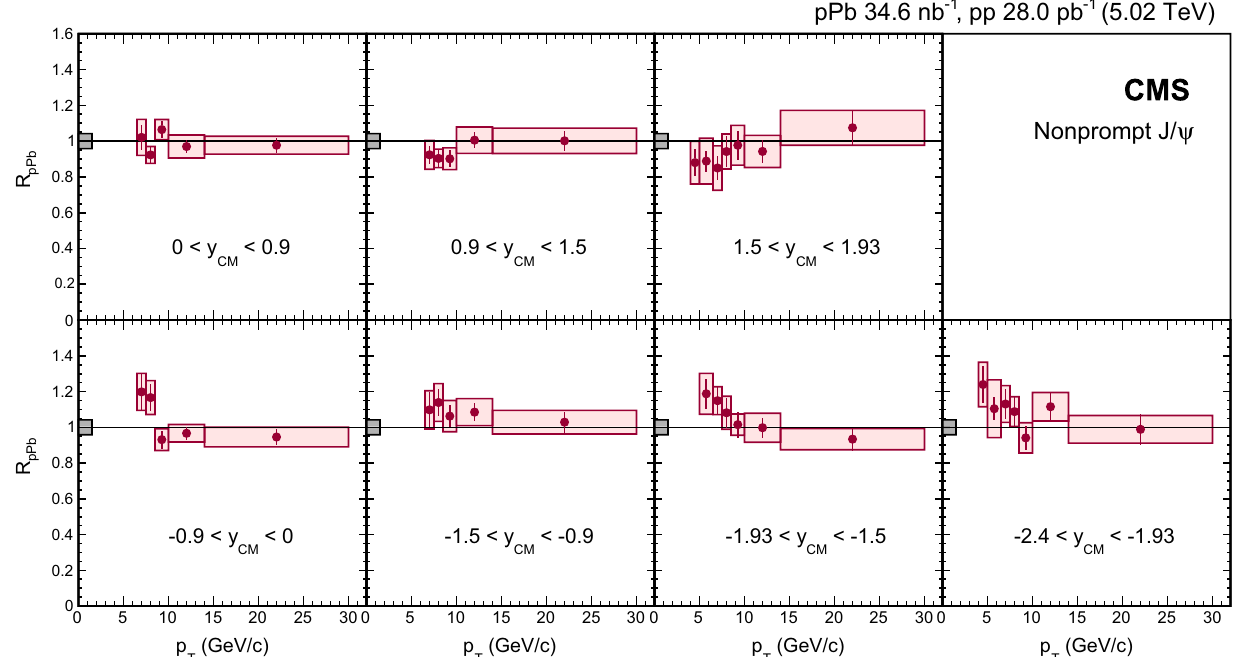
Fig. 10 Transverse momentum dependence of R pPb for nonprompt J /ψ mesons in seven y CM ranges. The vertical bars represent the sta- tistical uncertainties and the shaded boxes show the systematic uncer-